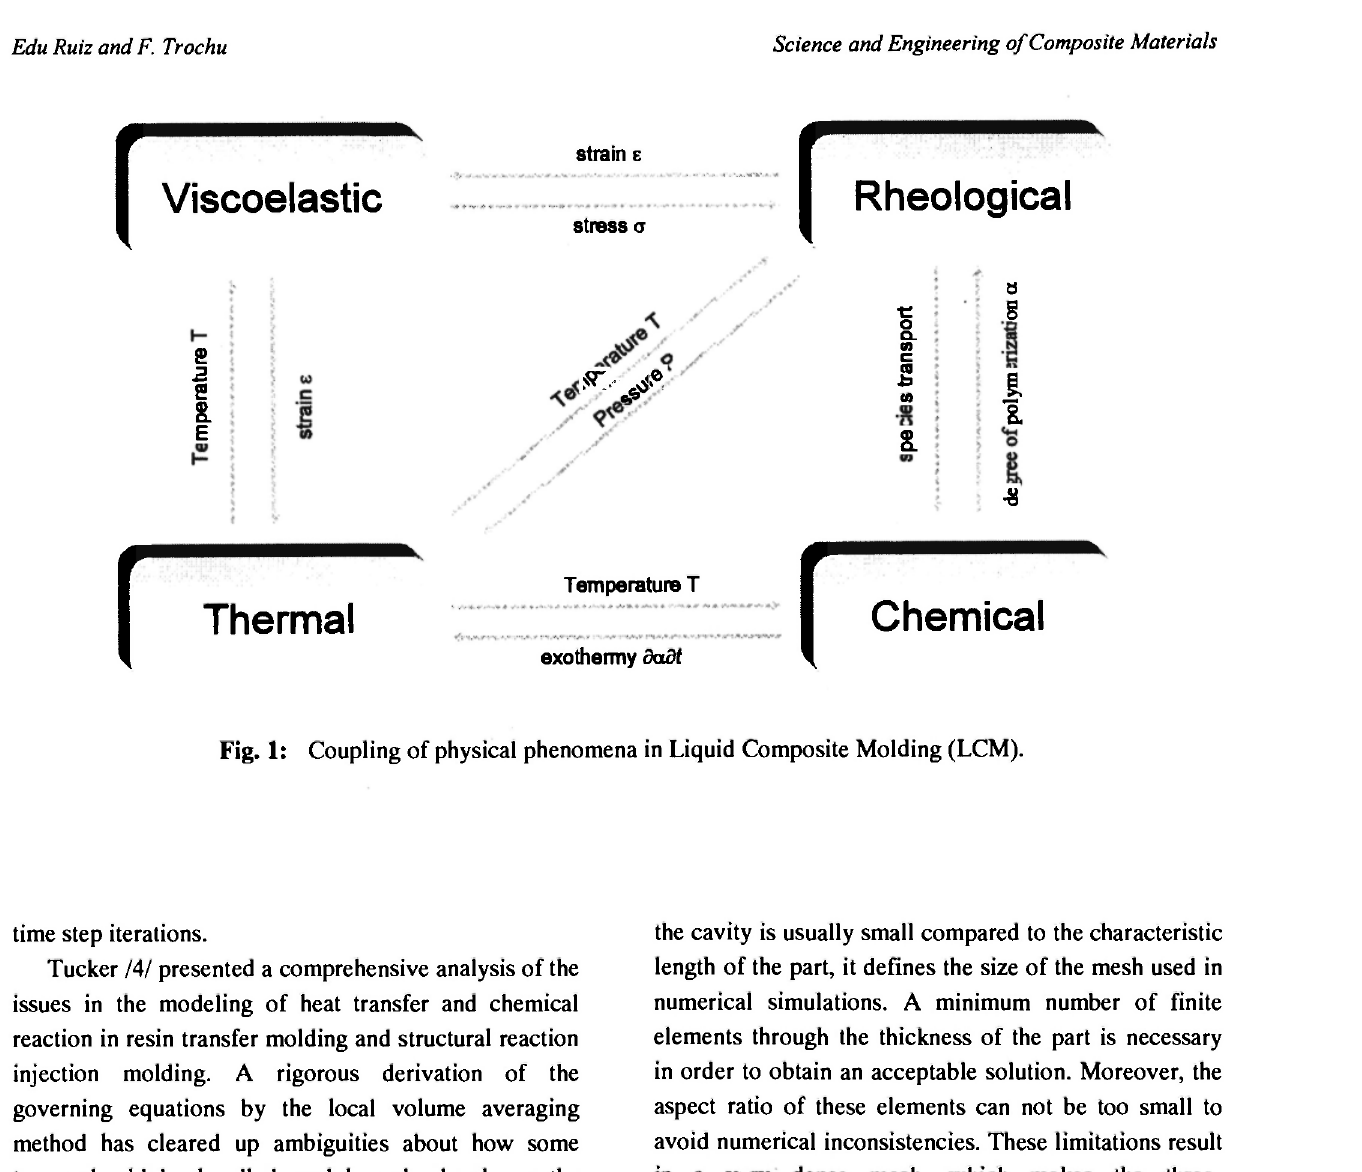
Fig. 1: Coupling of physical phenomena in Liquid Composite Molding